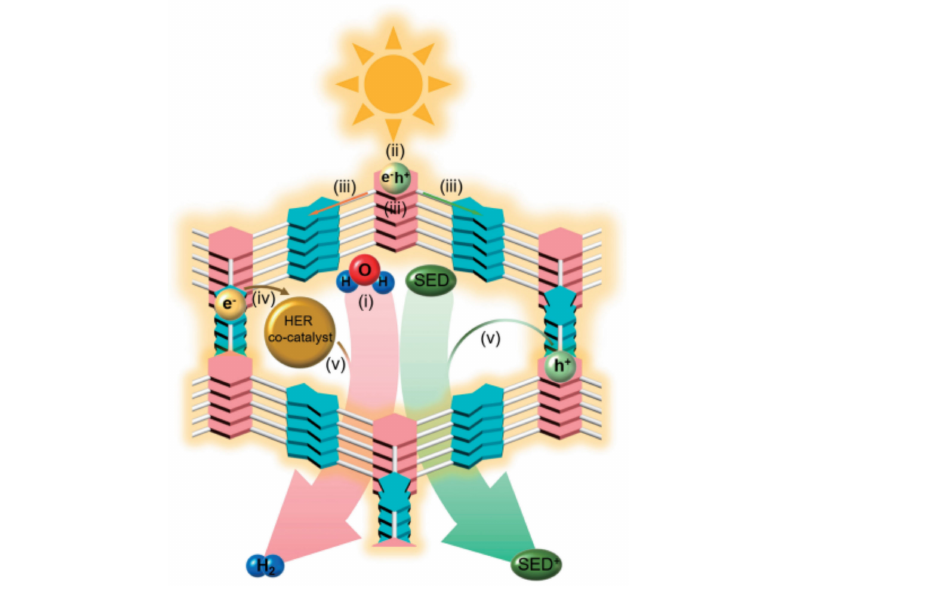
Figure 1. The complete process of photocatalytic hydrogen evolution reaction. Reproduced with permission from Ref. [34]. Copyright: The Chemical Society of Japan,